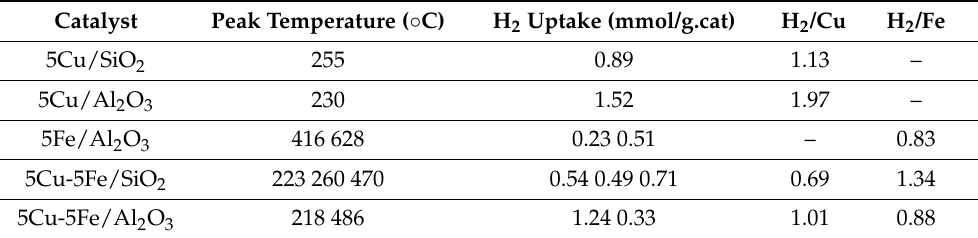
Table 1. H 2 uptake and reduction of peak temperatures of catalyst samples.